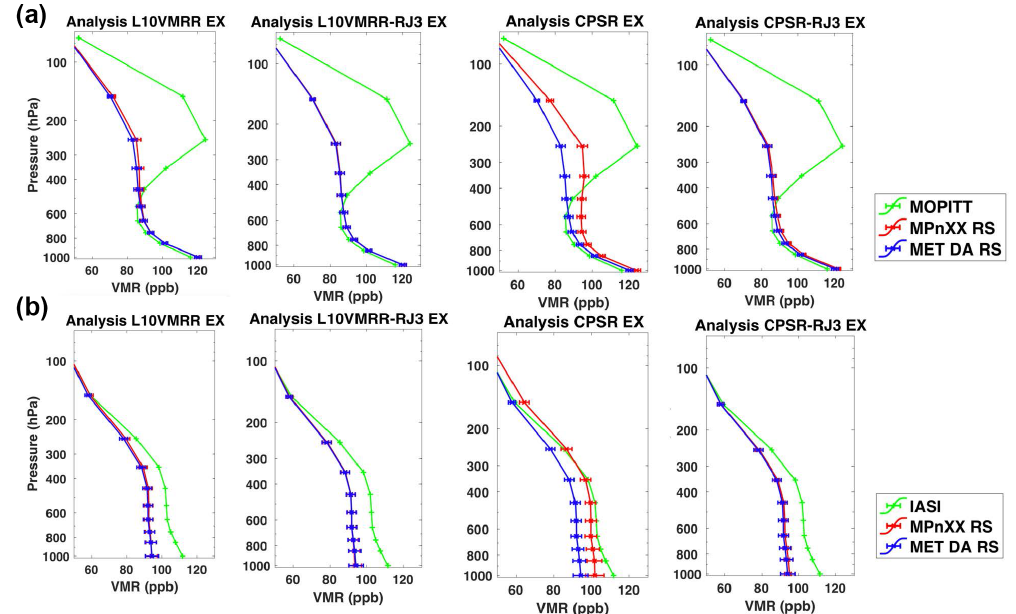
Figure 8. Same as Fig. 7 except this figure compares the L10VMRR, L10VMRR-RJ3, CPSR, and CPSR-RJ3 experiments. Panel (a) com- pares the forecast/assimilation results against MOPITT CO retrievals (assimilated), and panel (b) compares those results against IASI CO retrievals (not assimilated). In the legends, Chem EX is a placeholder for the L10VMRR-RJ3, L10VMRR, CPSR, and CPSR-RJ3 experiments depending on the panel.